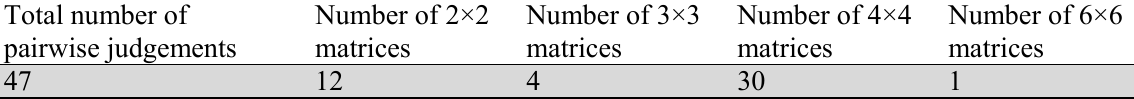
Number of pairwise judgements with different dimensions Total number of pairwise judgements